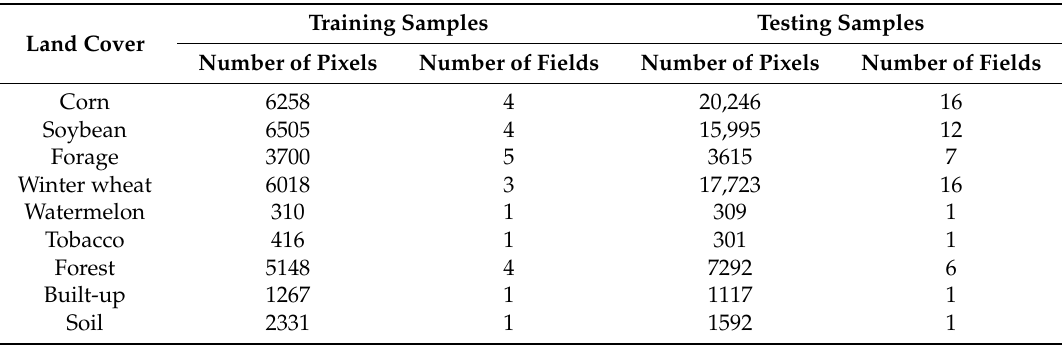
Table 2. The collected field data and the number of pixels for classification training and testing.